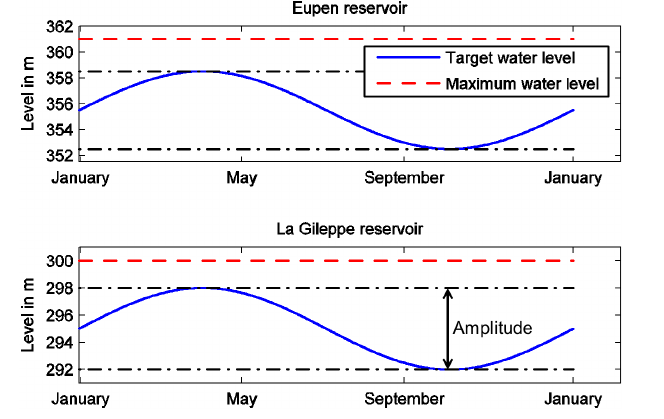
Figure 3. Target water levels and safety maximum water level in the Vesdre reservoirs.